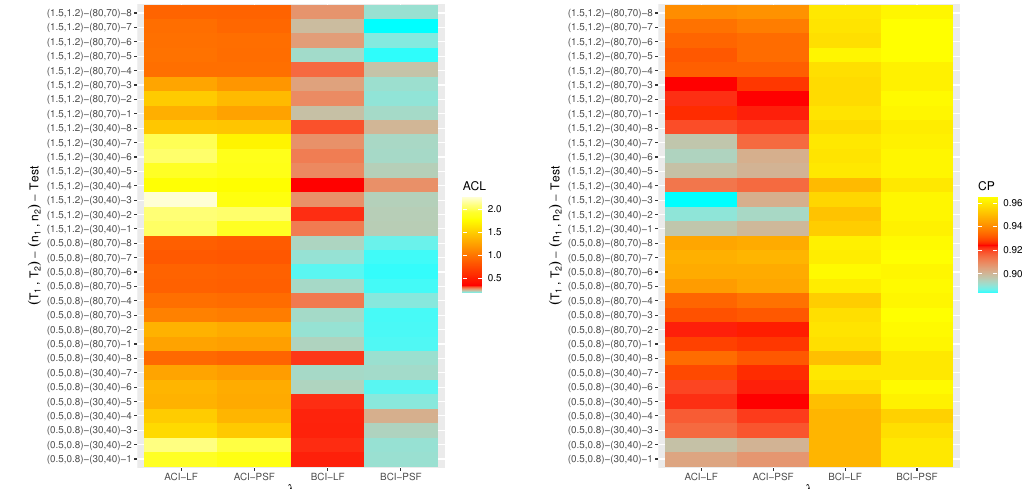
Figure 7. Heatmap for the estimation results of λ using Set 1.